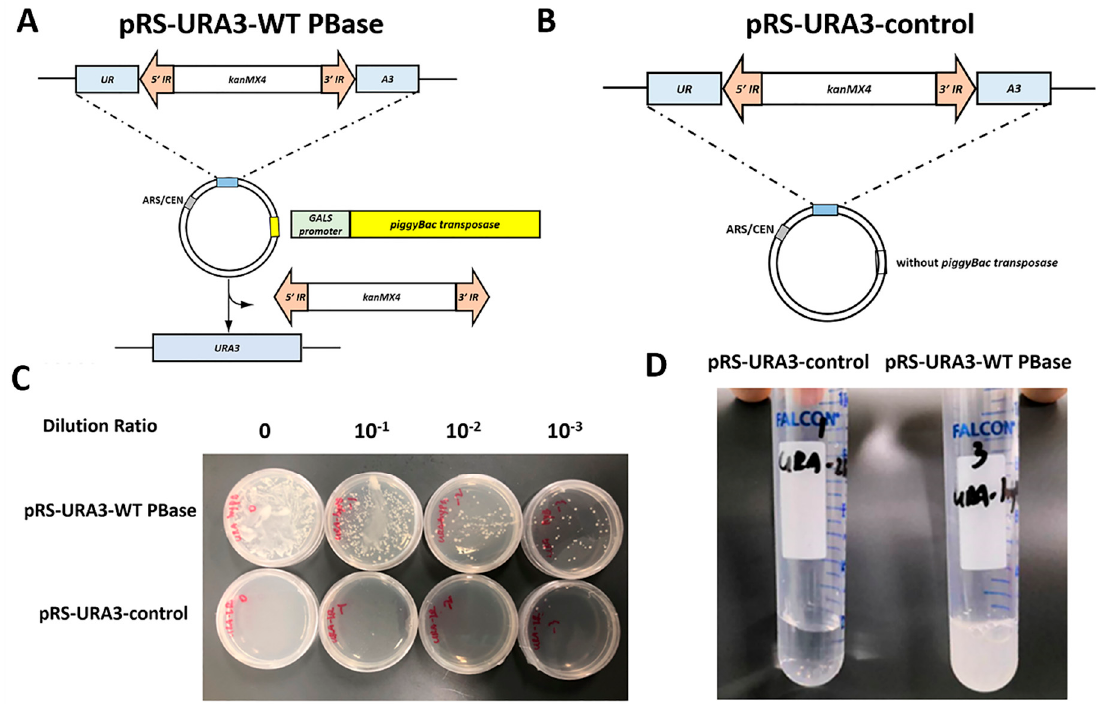
Figure 1. Efficient screening system in Saccharomyces cerevisiae . ( A ) Schematic representation of